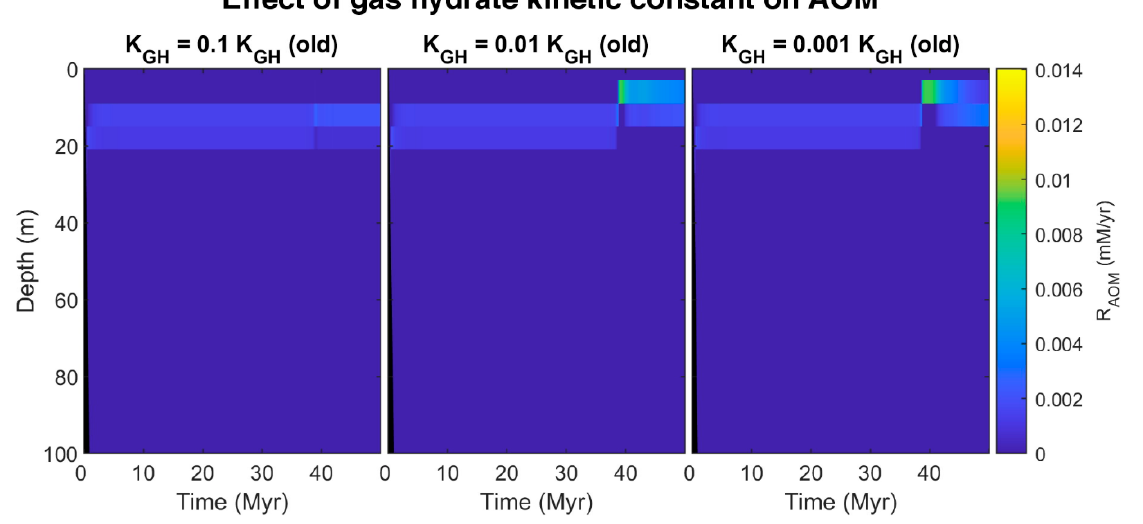
Figure 9. Simulated rate profile of AOM at different gas hydrate kinetic constant (0–100 mbsf).